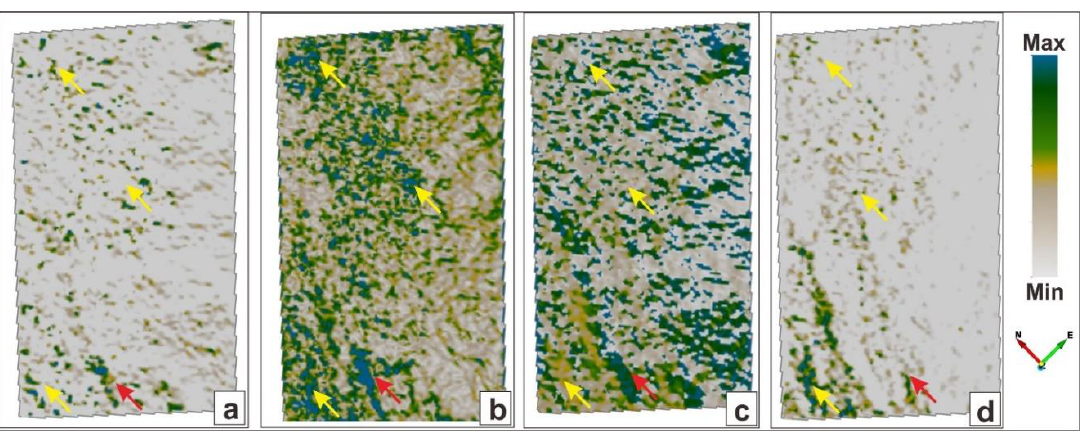
Figure 4. Time slices at 1780 ms of ( a ) inline-dip, ( b ) polar-dip, ( c ) azimuth, and ( d ) crossline-dip attributes. The yellow arrows show differences in discontinuities, while the red arrow shows a small scale faults (SSF). The results of the polar-dip were more effective in highlighting the discontinuities.